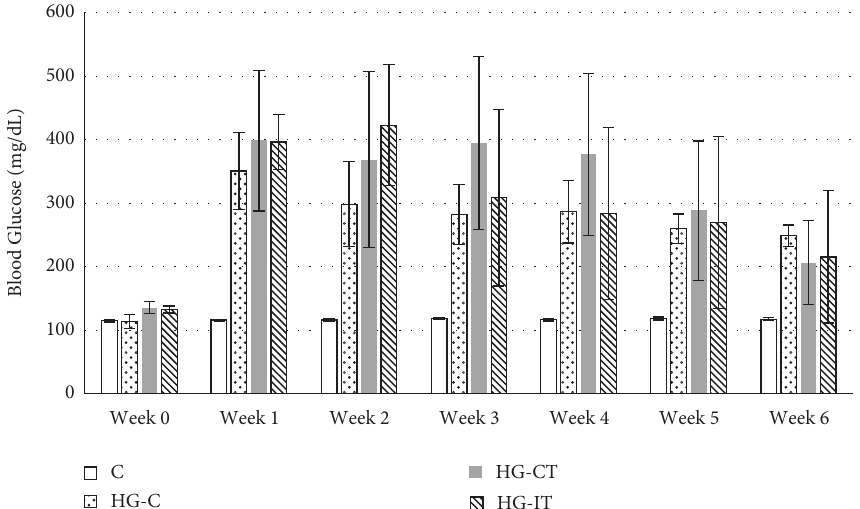
Figure 1: Te weekly blood glucose levels (mg/dL). c: control group; HG-C: hyperglycemic control group; HG-CT: hyperglycemic rats that performed moderate-intensity continuous training (MICT); HG-IT: hyperglycemic rats that performed high-intensity interval training